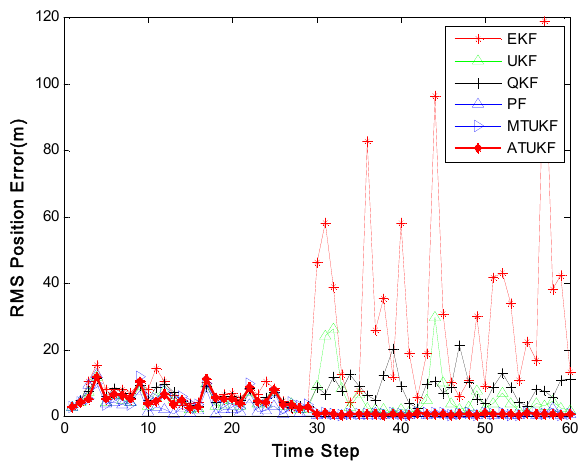
Figure 2. Root-mean-square (RMS) position errors of the extended Kalman filter (EKF), unscented Kalman filter (UKF), quadrature Kalman filtering (QKF), PF, mixture truncated unscented Kalman filter (MTUKF) and auxiliary truncated unscented Kalman filtering (ATUKF).